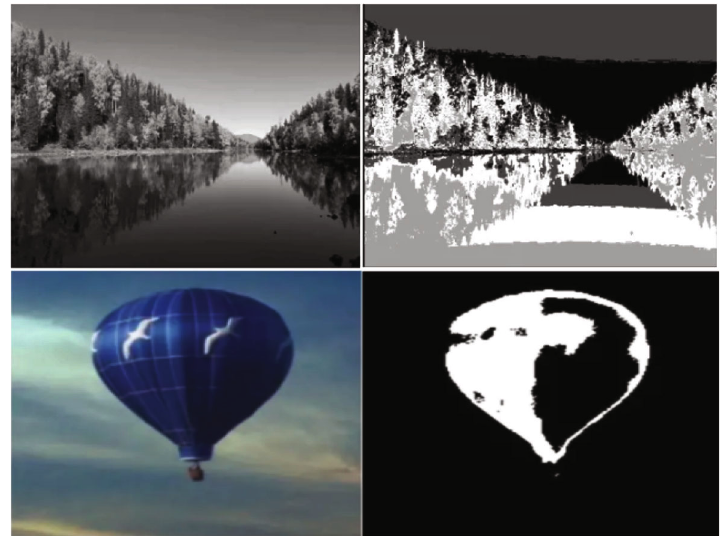
Figure 3: Example of image semantic segmentation.